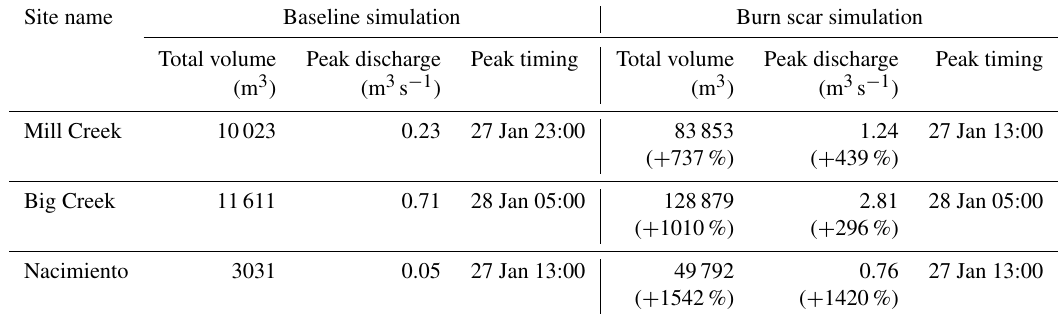
Table B4. The total runoff volume, peak discharge, and peak timing in the baseline and burn scar simulations from 27 January 00:00 to 31 January 23:00 at source areas of Rat Creek, Mill Creek, Big Creek, and Nacimiento debris flows (black circles in Fig. 7b–d). The percent changes in the total volume and peak discharge in the burn scar simulation relative to the baseline simulation are shown in parentheses.